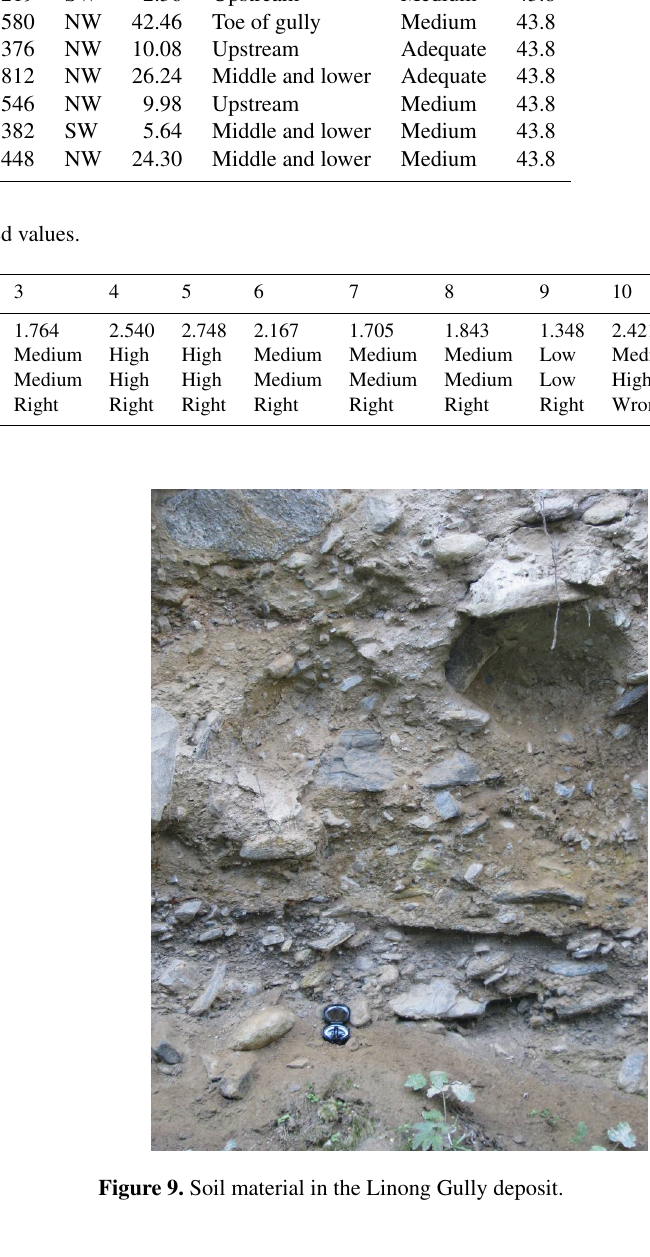
of the gully, catchment morphology, valley orientation, loose material reserves, location of the main loose ma- terial, antecedent precipitation, and rainfall intensity. 2. A total of 70 typical debris flow gullies distributed along the Brahmaputra River, Nujiang River, Yalong